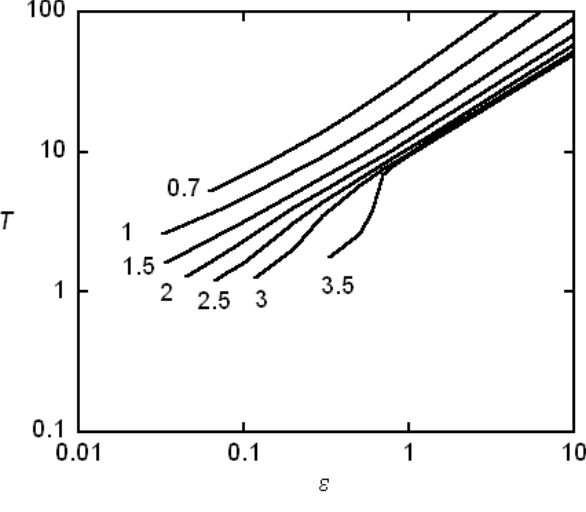
Fig. 5. Cycle period T as a function of ε for the MBG model with β =5.5 and for various values of Q o , as indicated on the curves. Parameters values as in Table 1.